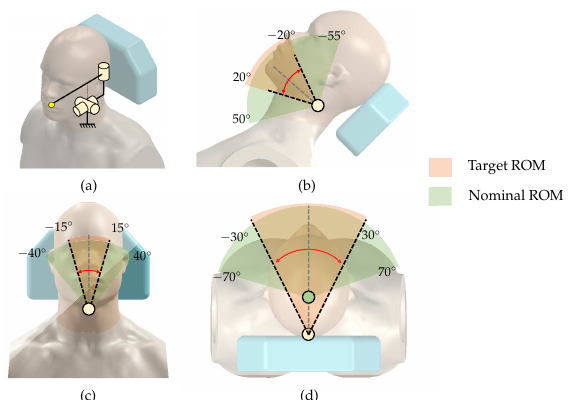
Figure 1. Head range of motion: ( a ) head–neck movement equivalent model; ( b ) cervical flex- ion/extension; ( c ) left/right lateralization; ( d ) left/right rotation.